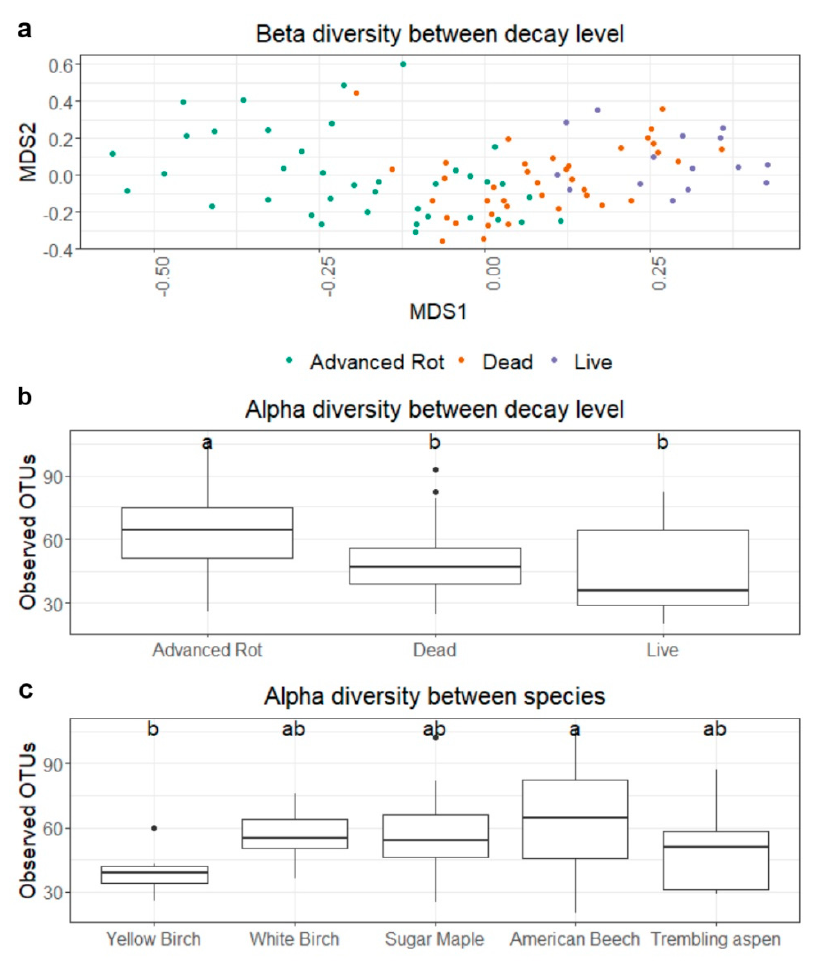
Figure 4. Beta diversity (nonmetric multidimensional scaling ordination of fungal community structure based on Bray-Curtis dissimilarity) between decay levels ( a ) and alpha diversity (expressed by the number of observed OTUs) between decay level ( b ) and species ( c ). Different letters indicate significant means difference, according to Tukey’s multiple comparisons of means test, with a 95% family ‐ wise confidence interval.